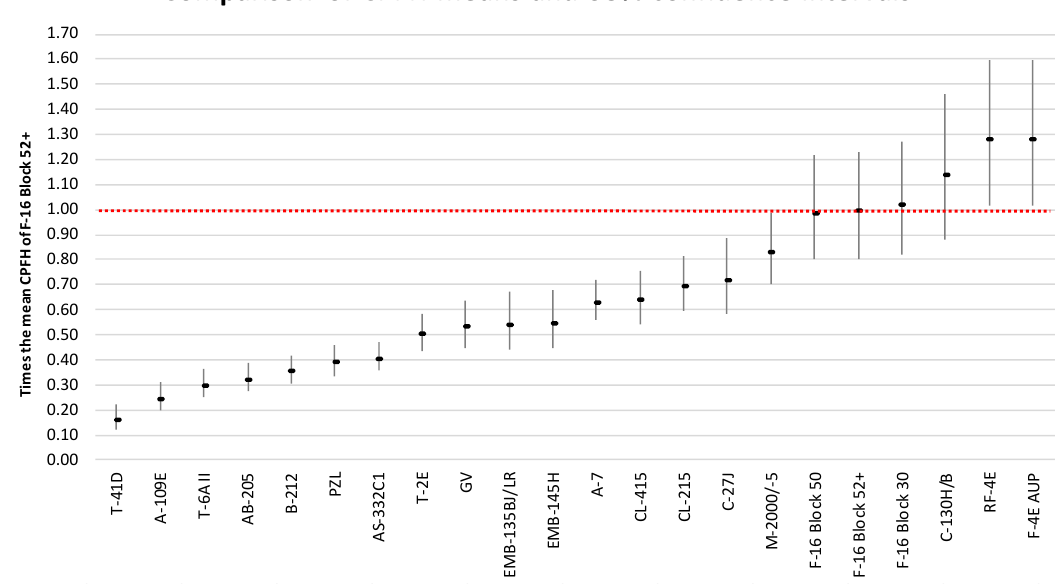
Figure 9. Comparison of mean CPFH and 95% CI for the training sample. Table 6. Comparison of mean CPFH and 95% CI for the training sample. The figures indicate ‘times the mean CPFH of F-16 Block 52+.’